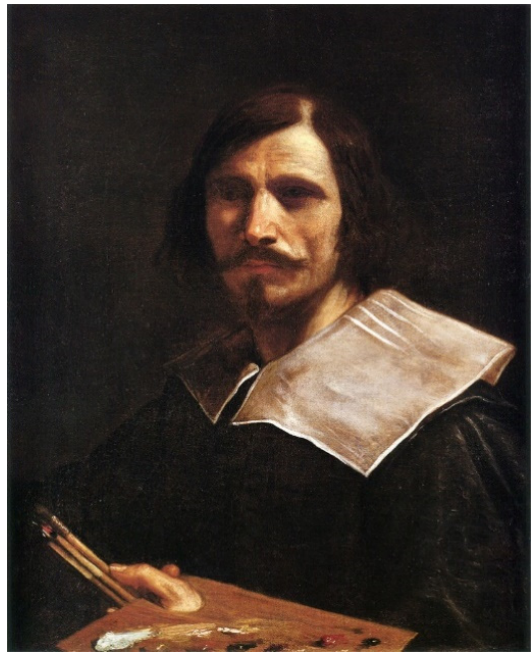
Figure 12. Guercino, Self-Portrait , 1635/40, London, Schoeppler Collection. Photo: Wikiart, Public Domain.